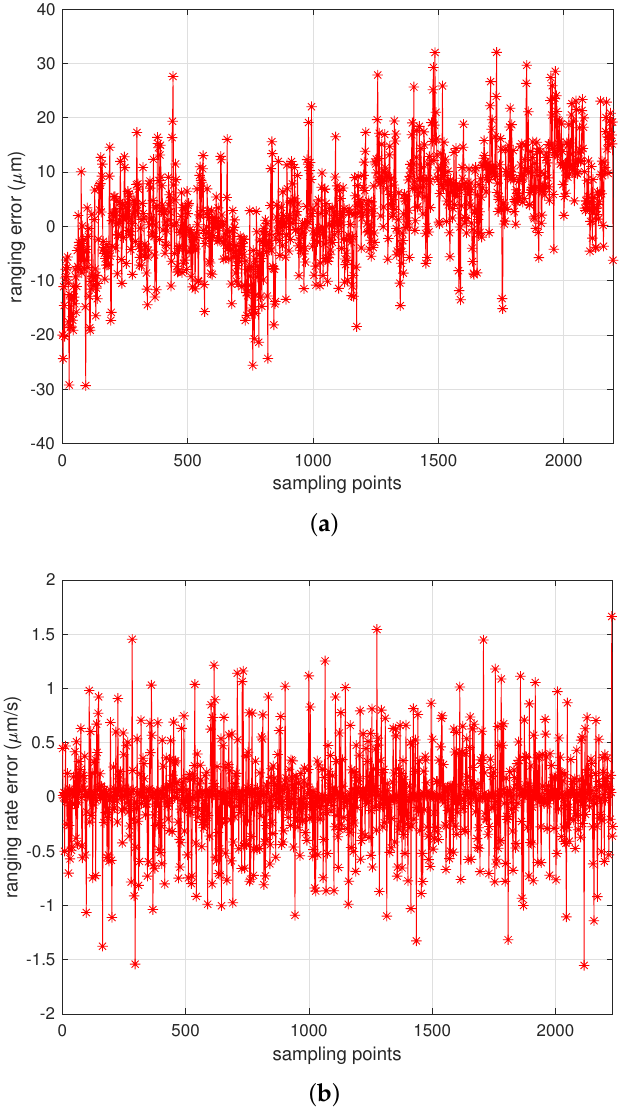
Figure 10. DOWR performance of MWR equipment with data collected from a 6-DOF moving platform under a relative longitudinal velocity of 5 µ m/s. ( a ) The ranging error of 2400 samples, achieving less than 40 µ m during the test. ( b ) the range rate error that less than 1.6 µ m/s during